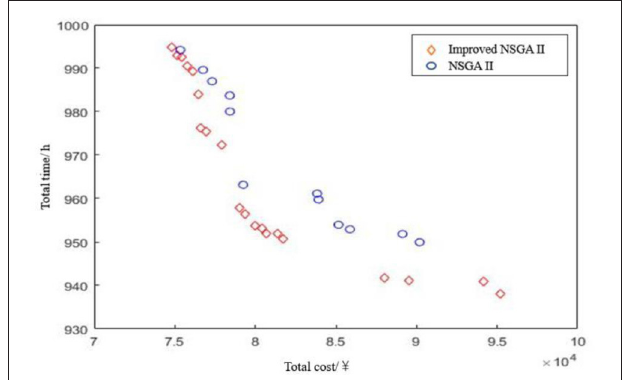
FIGURE 5 | Two multi objective genetic algorithms.